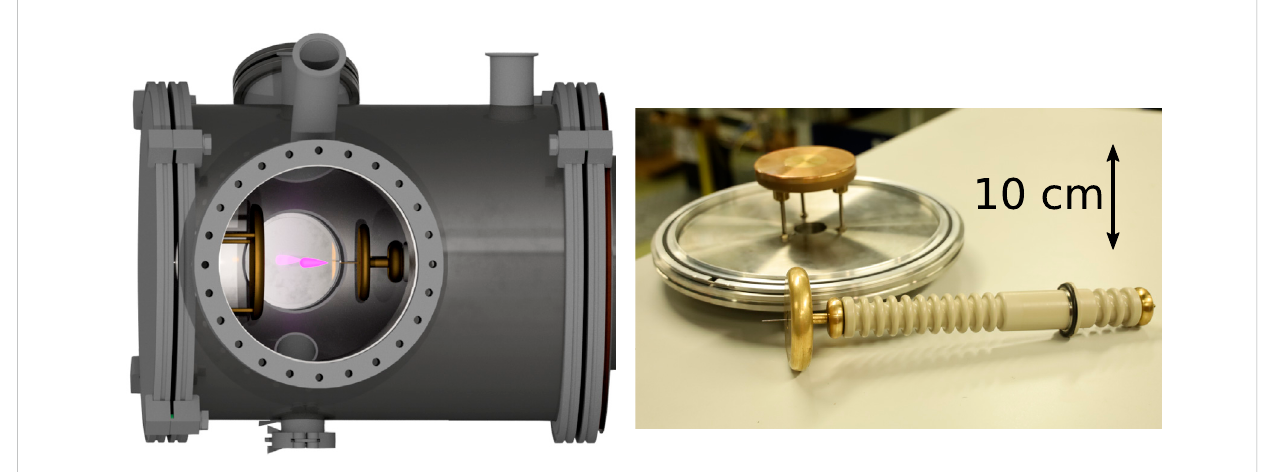
FIGURE 1 Onthelefta3Drenderofthedischargevessel,includingarepresentationofastreamerpropagatingthroughthedischargegap,shown propagating fromrighttoleft.The imageisrenderedfromtheviewpointofthemonochromator entranceslit andICCDcamera, viewingthedischargeandelectrodes through a large quartz window. On the right the unmounted electrodes, with the grounded electrode screwed to the vessel fl ange and the powered electrode with rod and PEEK KF40 feed though.